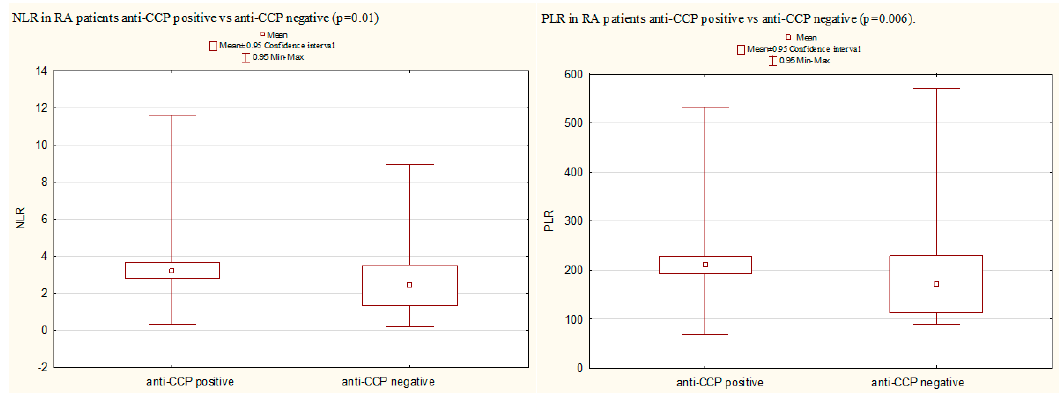
Figure 3. A comparison of NL and PLR in RA anti-CCP positive patients vs. anti-CCP negative patients (Mann–Whitney U test). Anti-CCP, anti-citrullinated peptide/protein antibodies; NLR, neutrophil-to-lymphocyte ratio; PLR, platelet-to-lymphocyte ratio; RA, rheumatoid arthritis.